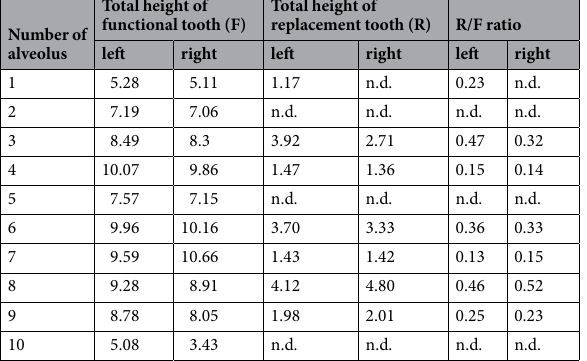
Table 4. Tooth height and the R/F ratio in the upper jaws of CAGS-IG-VD-002. n.d. = not developed. All measurements in mm.